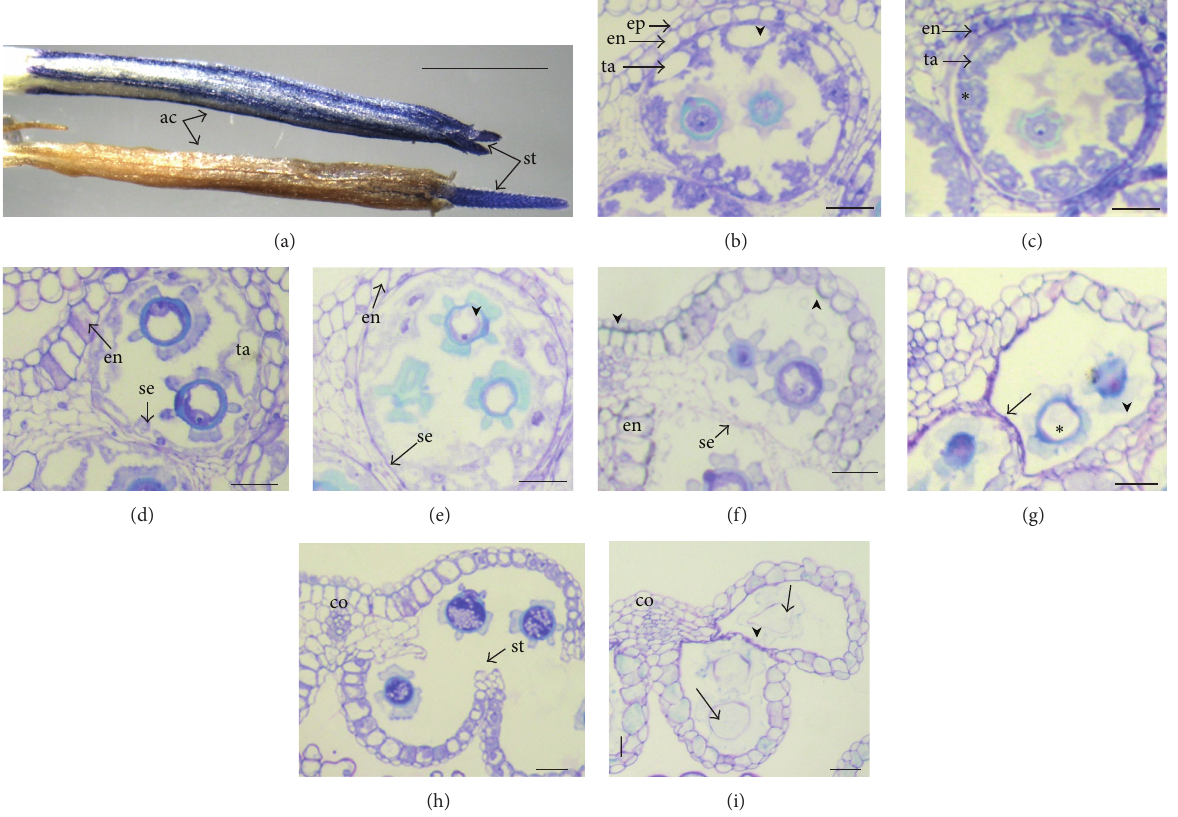
Figure 5: Anther and pollen development in fertile CC line and in 524CC male sterile anther. (a) At anthesis, the fertile anther is blue colored and the sterile is brown and shriveled; the stylar branches (st) arising on the top of the anther column (ac) are normal and blue colored in both cases. ((b), (d), (f), and (h): fertile anthers; (c), (e), (g), and (i): sterile anthers). (b)-(c) Free microspore stage (stage 10). In fertile flower (b) the tapetum has larger vacuoles (arrow heads) and in male sterile flower (c) the vacuoles are numerous but smaller and less significant intrusion of tapetal cells is observed at this stage ( ∗ ). (d)-(e) Vacuolated uninucleate pollen grain stage (stage 11). The endothecium (en) expansion is noticeable in (d) not in (e) where the pollen cytoplasm is diffuse (arrow head). (f)-(g) Two-celled pollen grain (stage 13), (f) connectivum and endothecium cell undergo wall lignification (arrow heads), (g) absence of cell wall lignification in the connectivum and endothecium, pollen abortion ( ∗ ), shrinkage of endothecium (arrow head) and septum (se) not opened (arrow). (h) The connectivum (co) and endothecium are lignified and the anther is dehiscent. (i) The septum and stomium (st) are unopened (arrow head). The pollen grain is degenerated (arrows), the connectivum is not lignified, and the anther is indehiscent. Bars 2mm in (a), 20 𝜇 m in